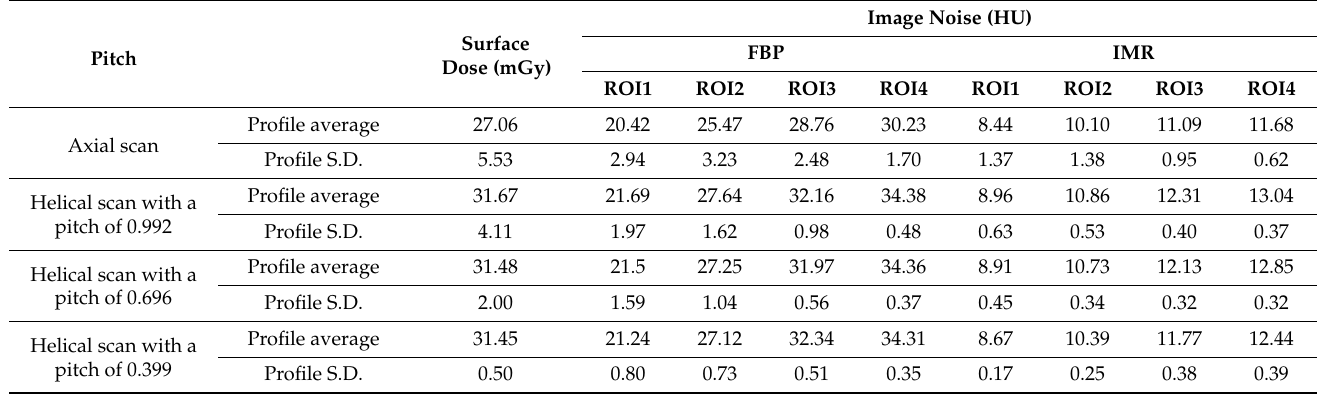
Table 2. Average values and standard deviations for ROI1, ROI2, ROI3, and ROI4 of reconstructed images by FBP and IMR for the axial and helical